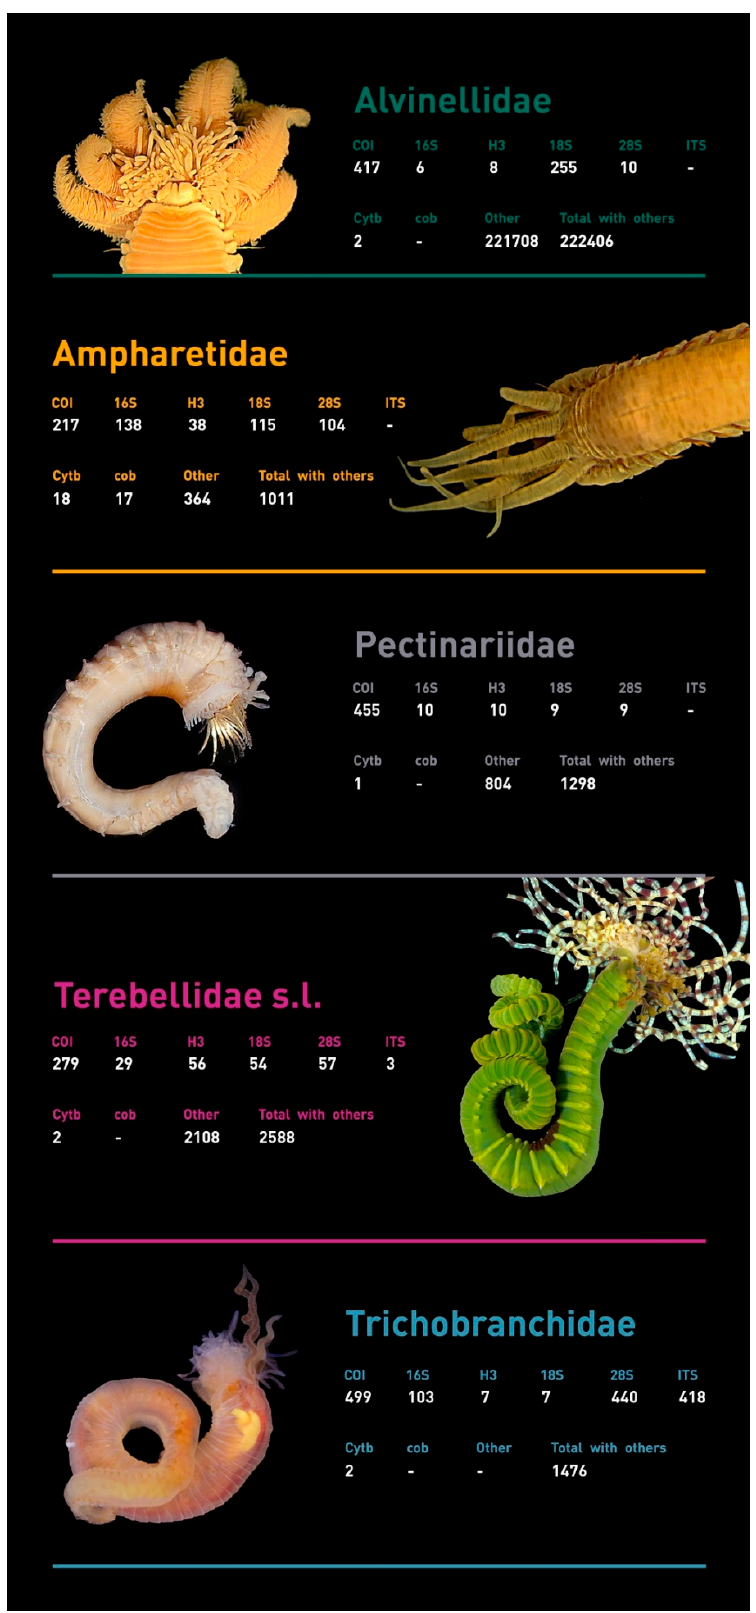
Figure 10. DNA sequences for Terebelliformia.